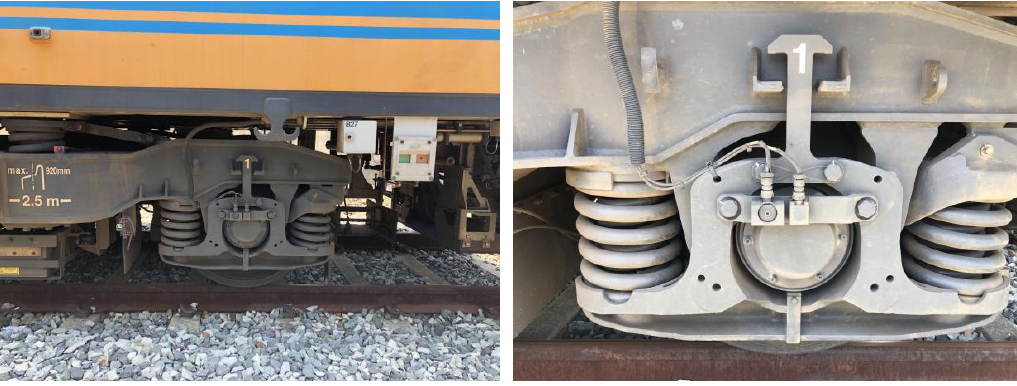
Figure 2. EM-140K accelerometer .